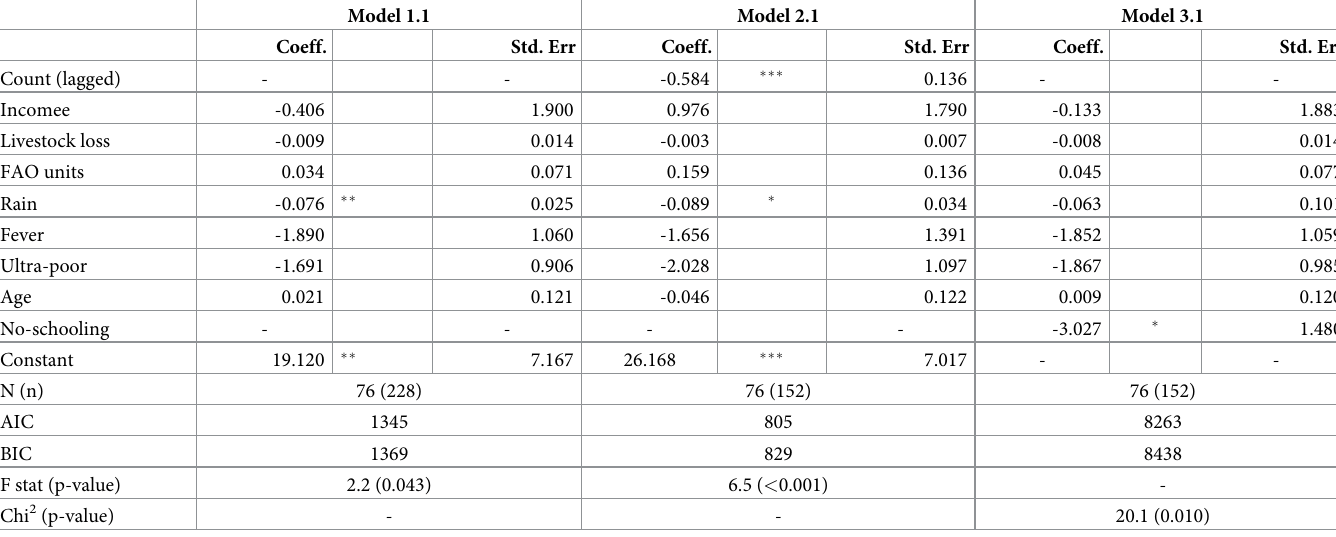
Table 5 estimates the same models, as used in Table 4, with livestock expenditure as the dependent variable. Neither of the cognitive ability variables, nor the heuristic use variable, are estimated to predict household livestock expenditure. The perception of household finances Table 3. Relationship between Complex Span Counting task and